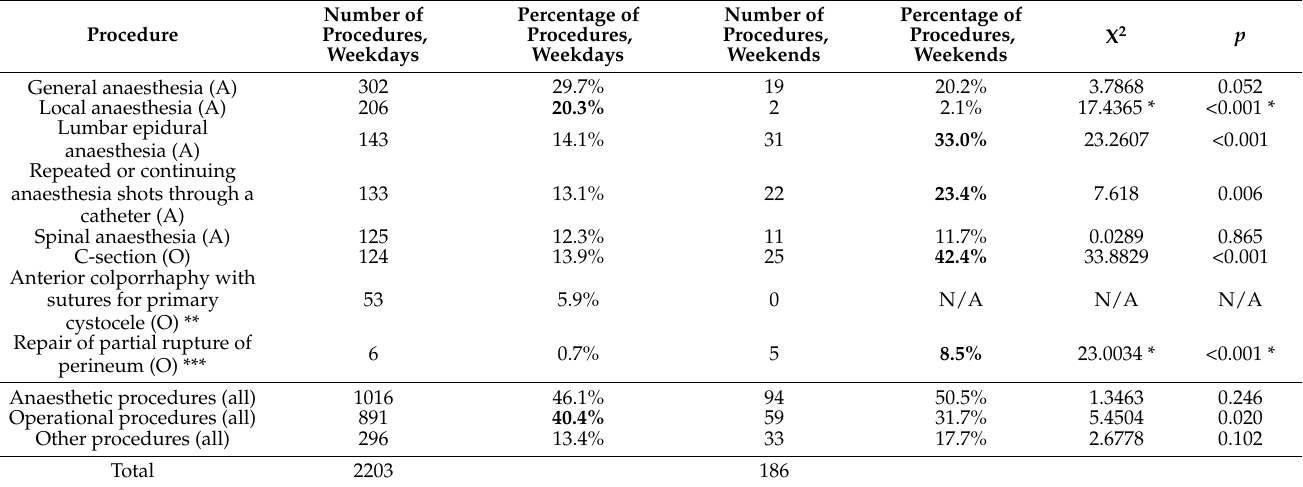
Table 4. Differences in reported procedures between weekdays and weekends, using chi-squared